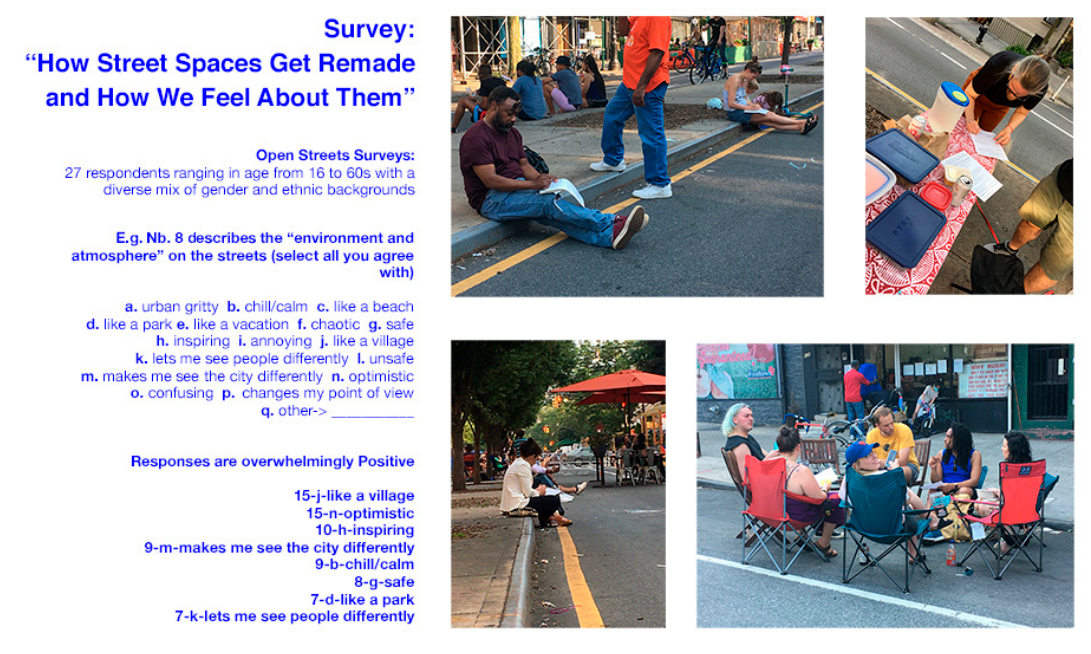
Figure 4. The varied array of people who filled out surveys responding to the present/future of Open Streets (Source: author)